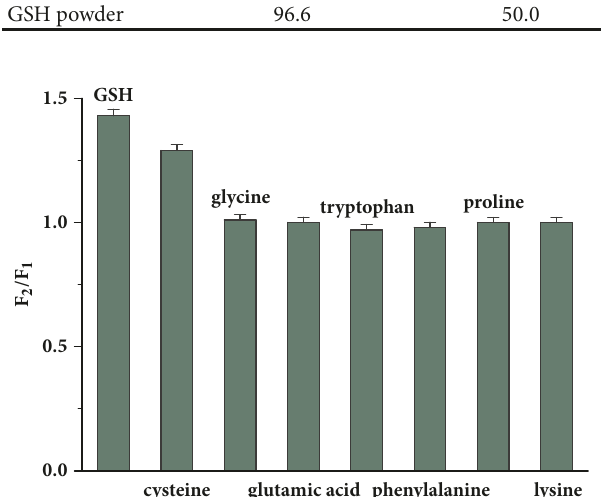
Figure 5: Selectivity of the sensor for GSH over amino acids (F 2 is thefluorescenceintensityof theAuNCs-BSAinthe presenceof Cu 2+ and GSH or amino acids.).